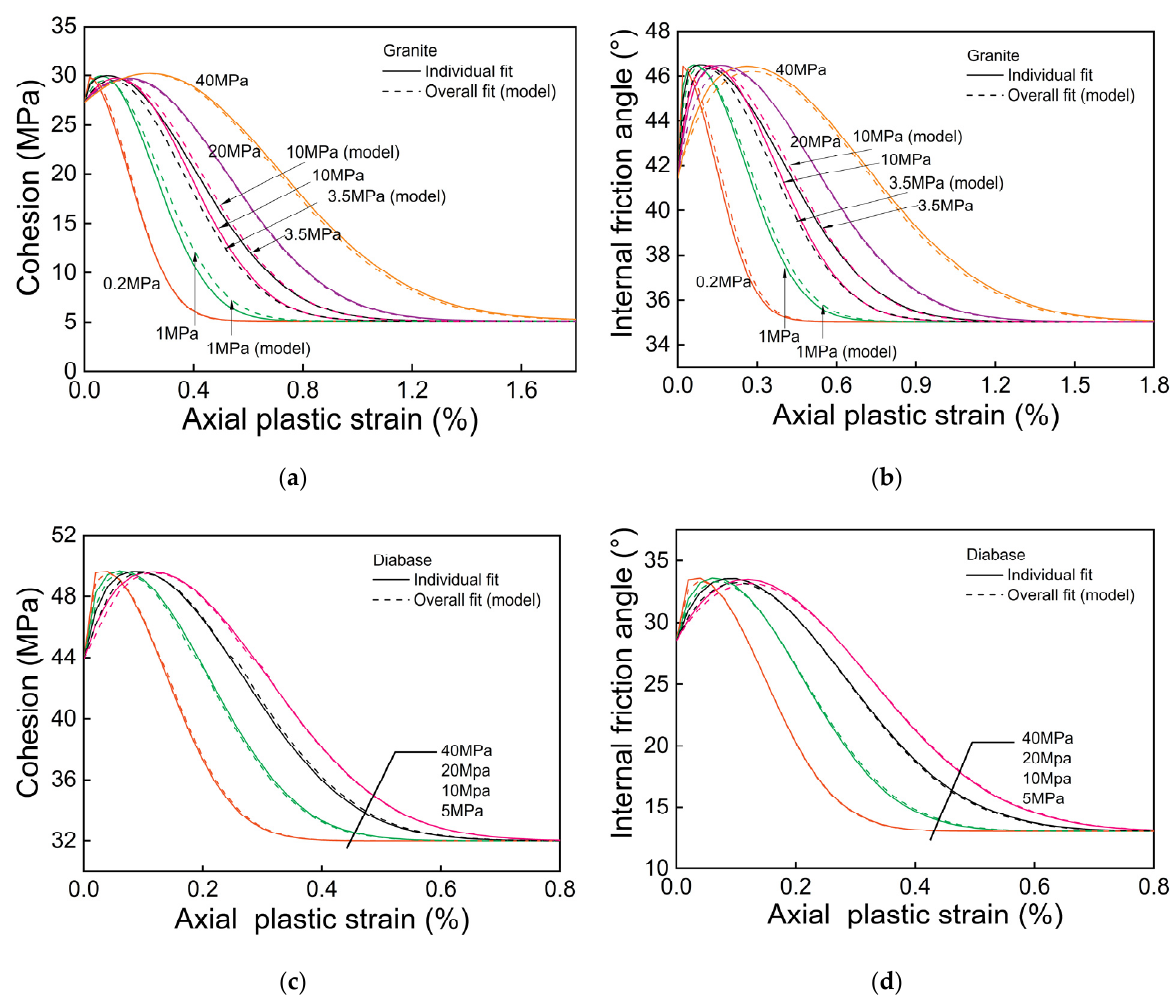
Figure 7. Comparison of the overall fit using the cohesion and internal friction angle and the individual fit of two hard brittle rocks at different confining pressures: ( a , b ) are for Beishan granite [26], and ( c , d ) are for Danjiangkou diabase [37].